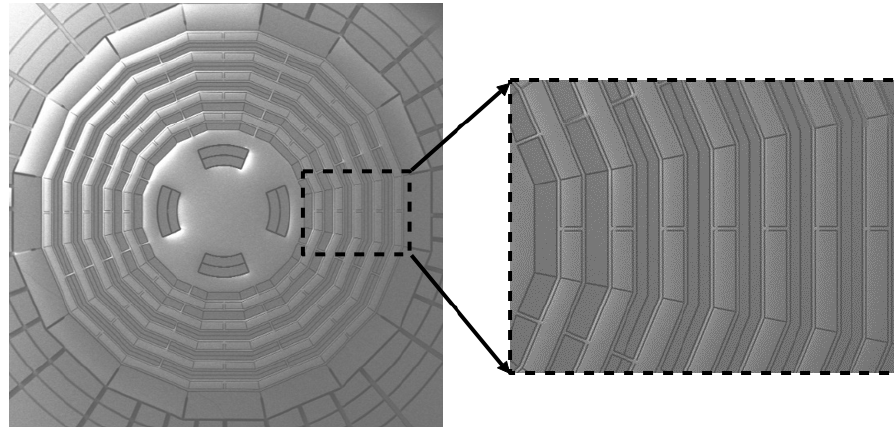
Figure 4. The SEM photo of the fabricated gyroscope.